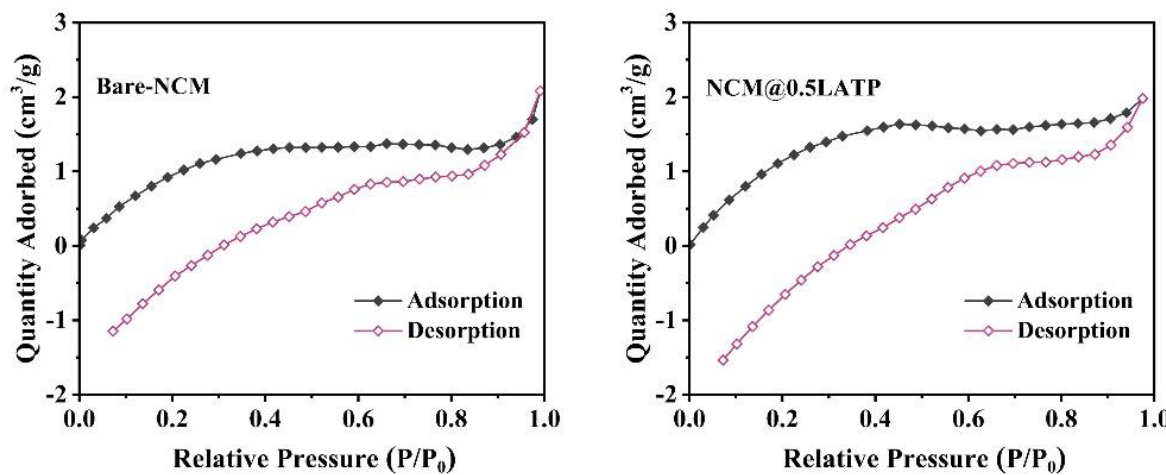
Figure 6. N 2 adsorption/desorption isotherms of bare NCM and NCM@0.5LATP.